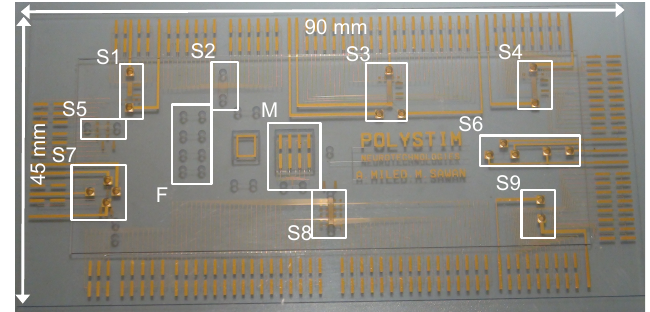
Figure 15. Microfluidic fabricated device using LioniX process.